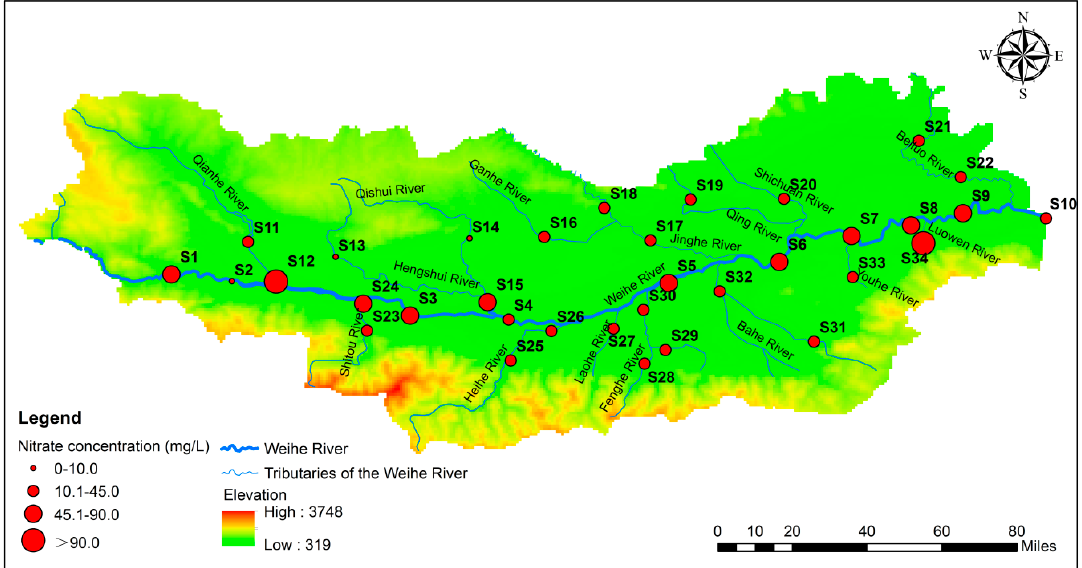
Figure 3. Spatial distribution of nitrate in the rivers.